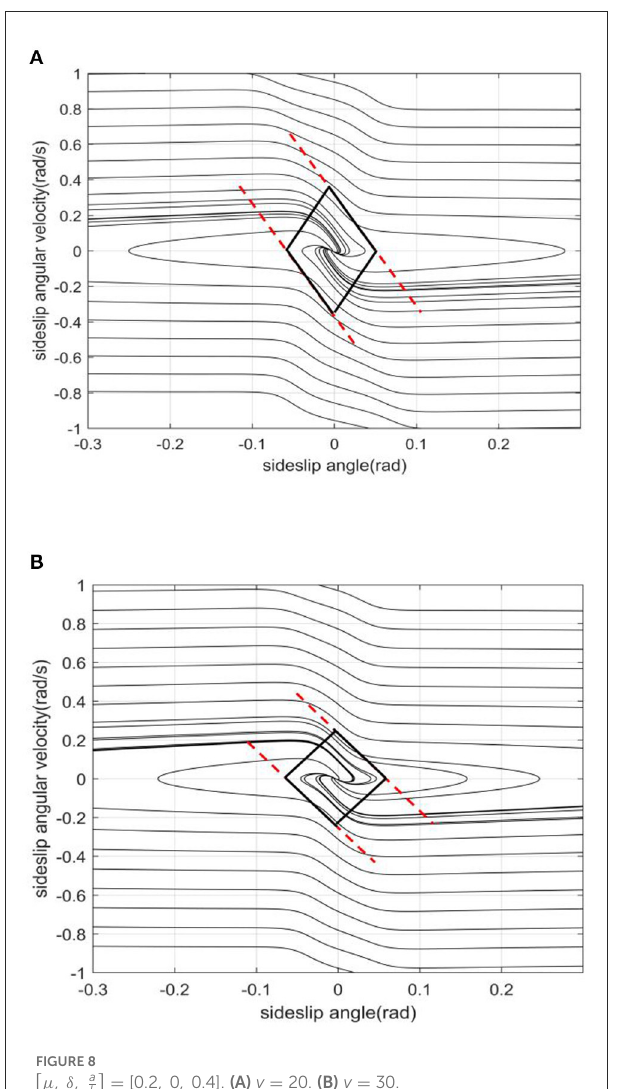
= [0.2, 0, 0.4]. (A) v = 20. (B) v = 30. µ , δ , a L (cid:3) (cid:2)